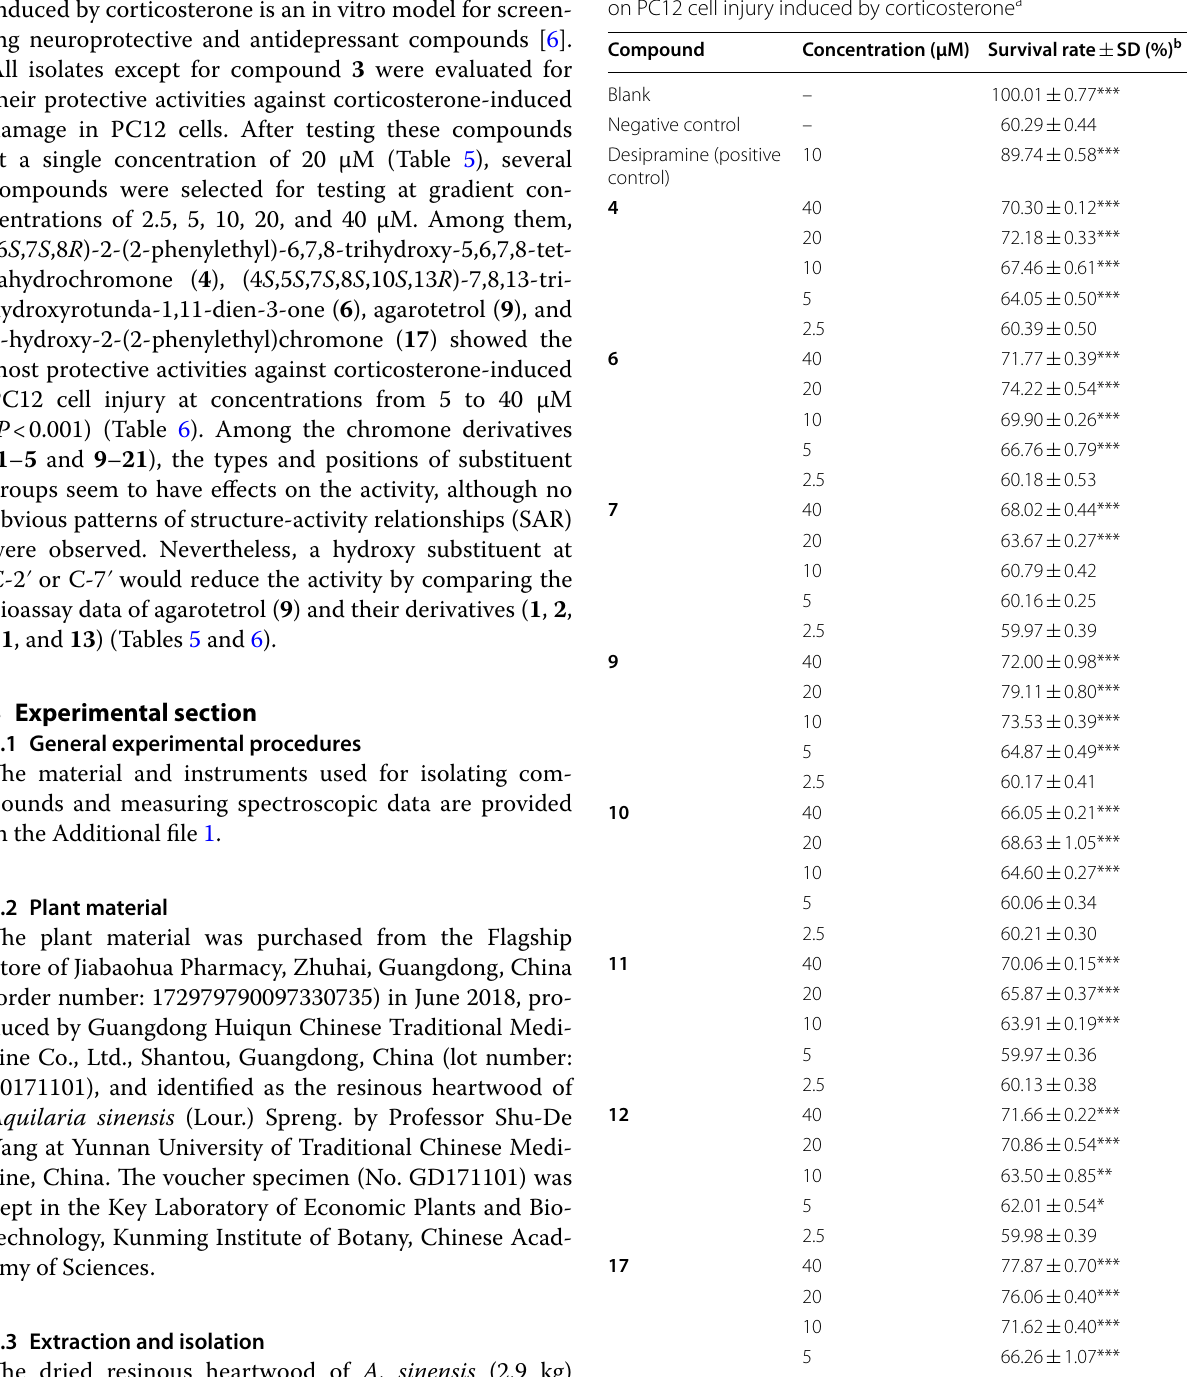
Table 6 The effects of compounds at gradient